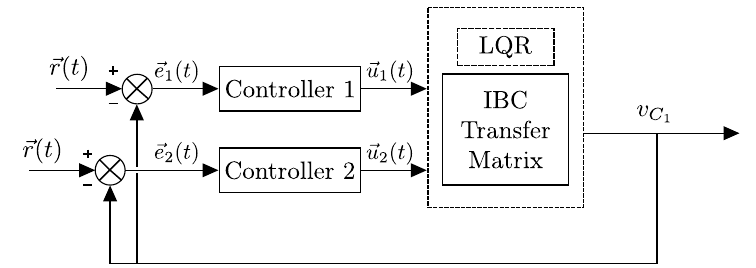
Figure 8. IBC MISO control scheme.